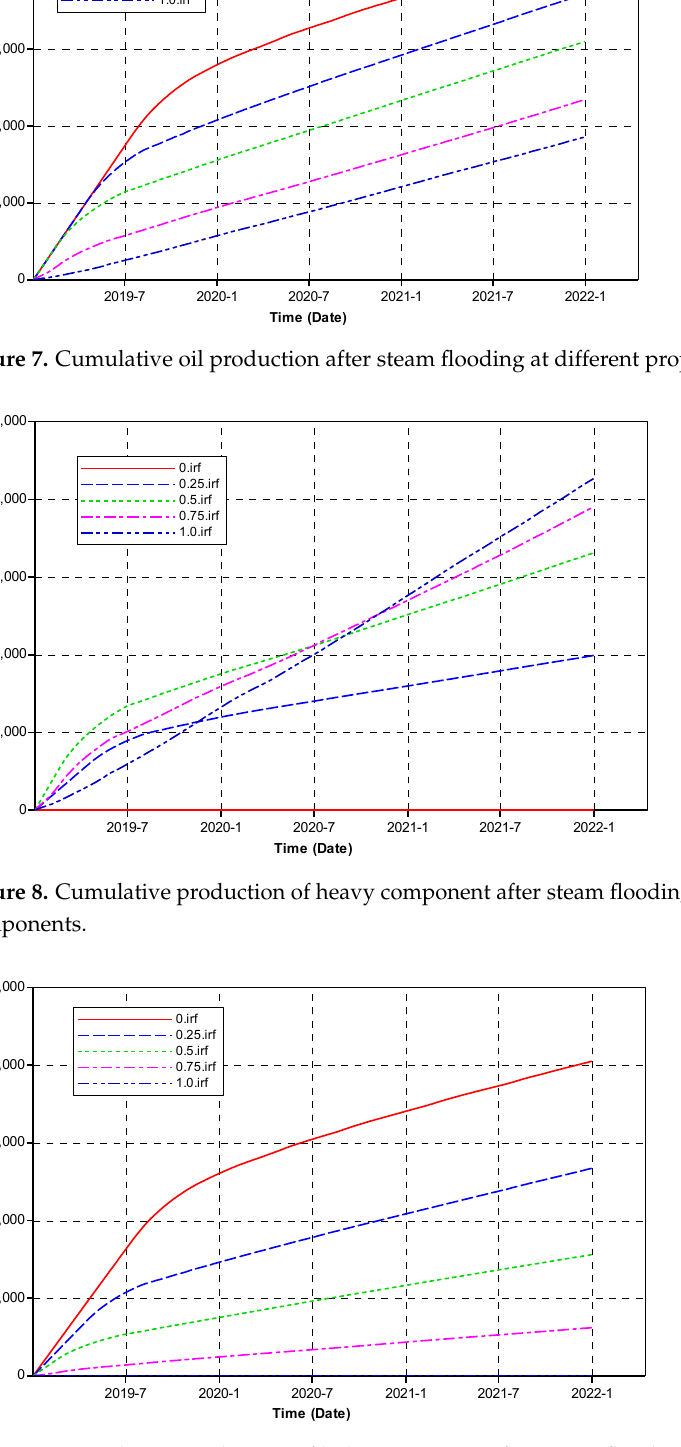
Figure 9. Cumulative production of light component after steam flooding at different proportion of components.